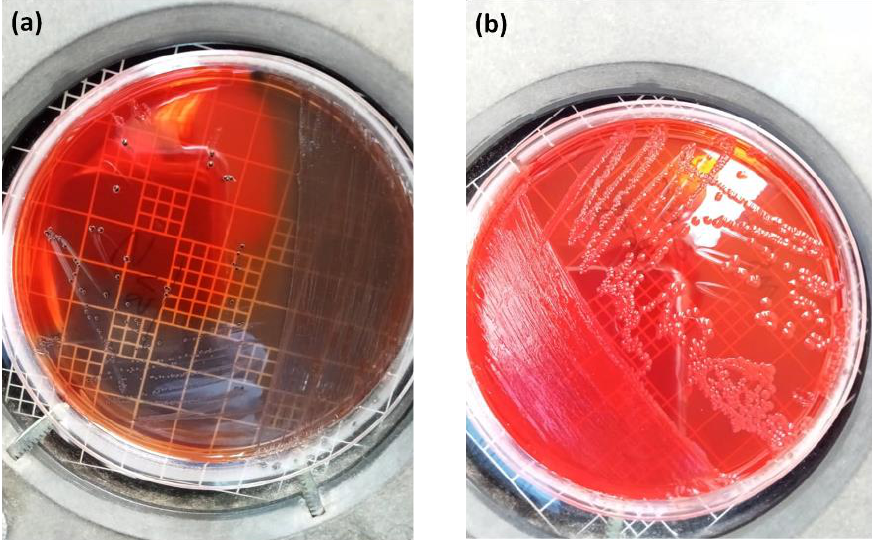
Figure 9. The appearance of strains cultured on Congo red agar. ( a ) colonies of Enterococcus faecalis Slime-producer; ( b ) Staphylococcus hominis strain, non-producing slime.